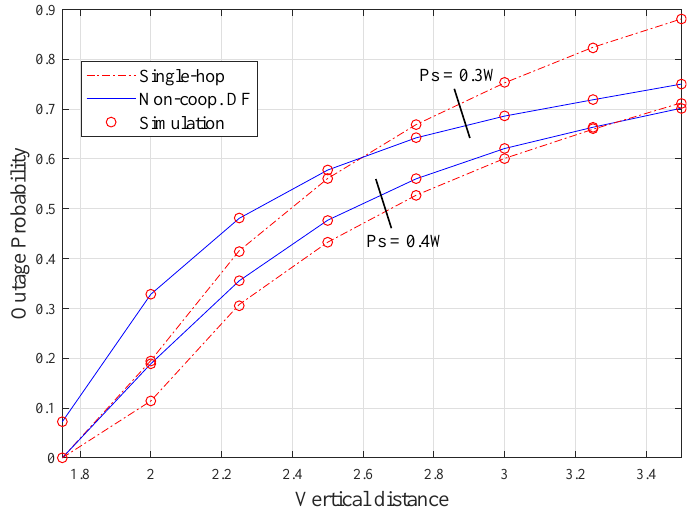
Figure 4. Outage probability of single-hop and non-cooperative DF relay